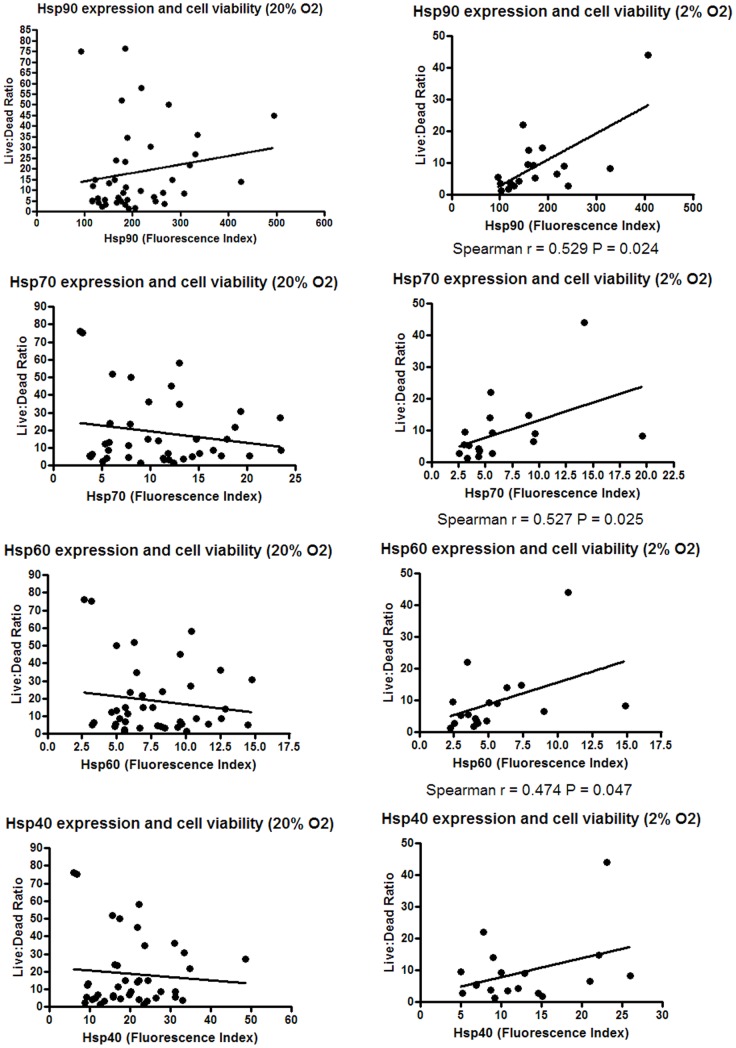
Effect of low oxygen culture on hsp expression.Forty two melanoma cell lines were cultured in 20% O2 and 18 of these cell lines additionally in 2% O2 for five days. Following the culture period, the cell lines were harvested and the number of living and dead cells determined using trypan blue. The ratio of live to dead cells was used as a marker of cell viability.